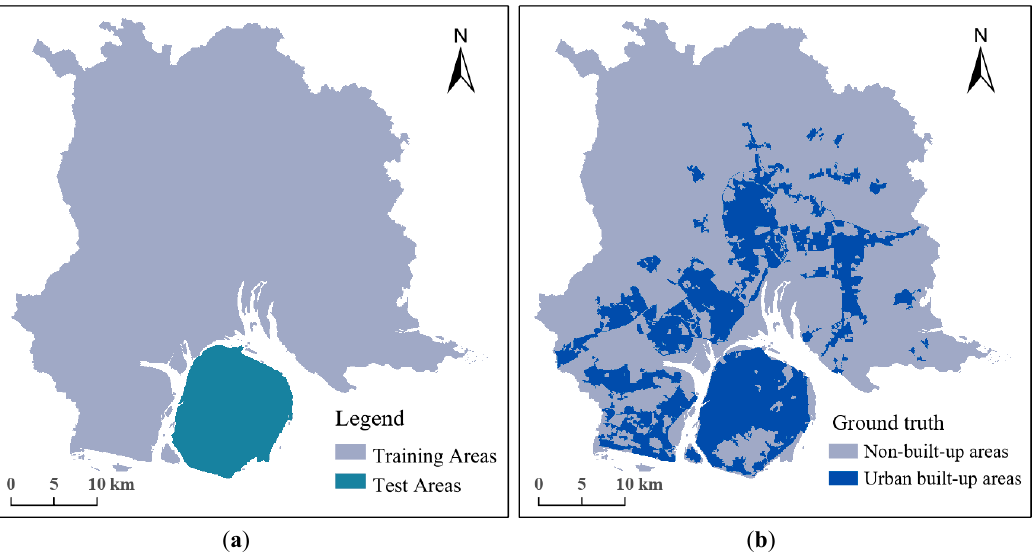
Figure 5. The ( a ) distribution of training and test sets and ( b ) spatial distribution of ground truth in the study area.